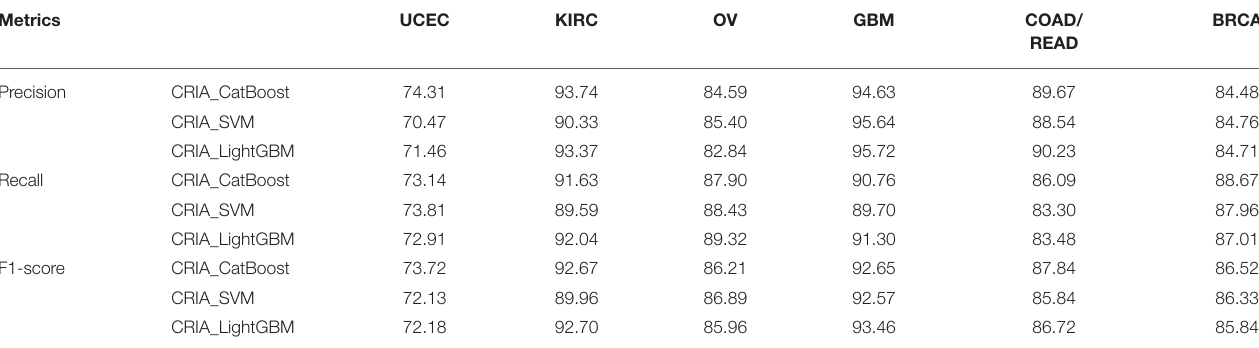
TABLE 7 | Average performance of precision, recall and F1-score on 10 test datasets with three classifiers via ten-fold cross-validation (%). Metrics